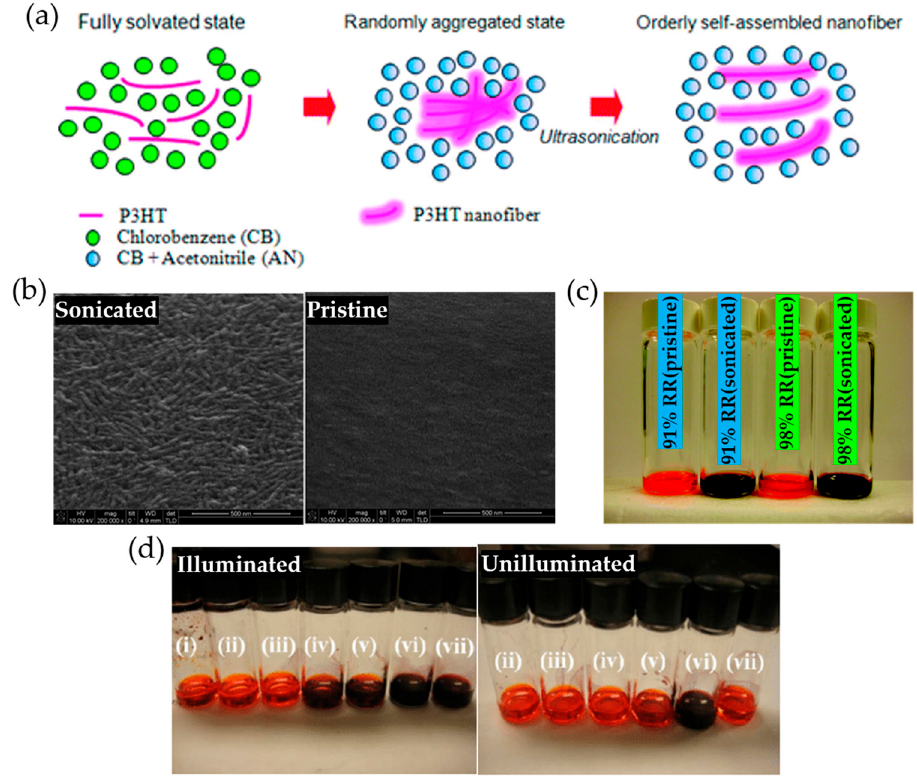
Figure 4. ( a ) Schematic illustration of P3HT aggregation in a solvent system containing a dipolar